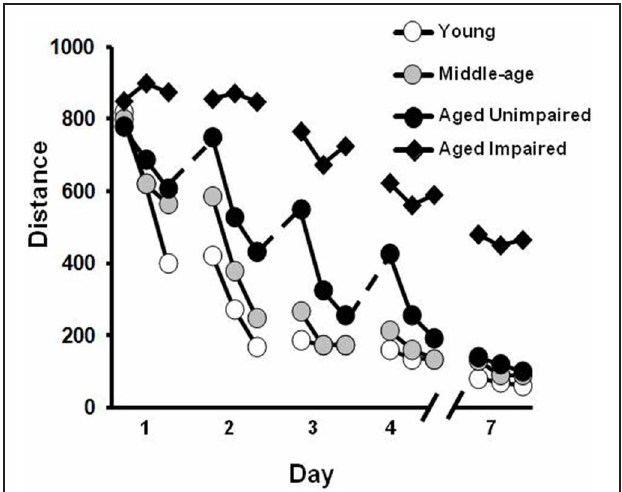
FIGURE 3 | Differences in acquisition of a spatial reference memory during training distributed across several days. The graph illustrates the distance to find the hidden platform during training trials each day for middle-aged (gray circles), and young (open circles) animals. Older animals may exhibit an initial saw-tooth pattern of performance across days (dashed lines) suggesting increased forgetting. However, this group is able to acquire a spatial reference memory over the course of training and is, therefore, classified as aged unimpaired (filled circles). In contrast, a subgroup of aged animals may exhibit profound learning deficits such that they are unable to acquire a spatial reference memory with repeated training to the same location (filled